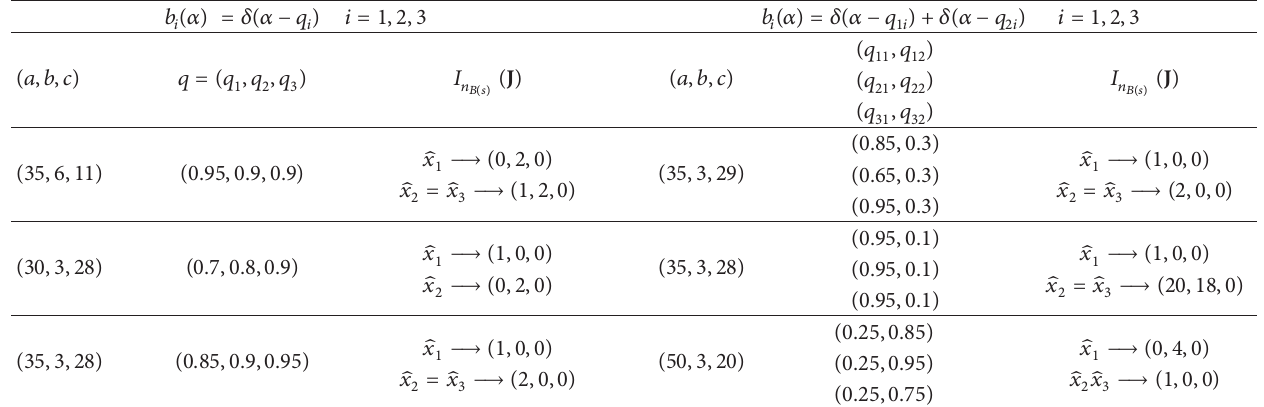
Table 1: Stability analysis of system (22) for various density